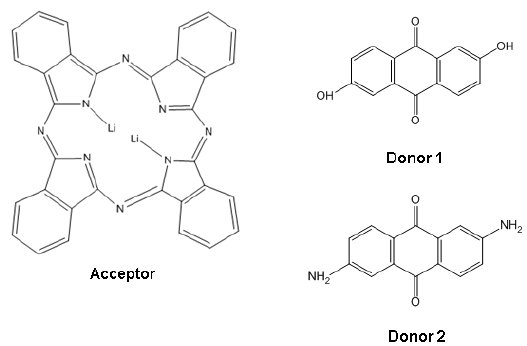
Figure 1. Acceptor and donor schemes.